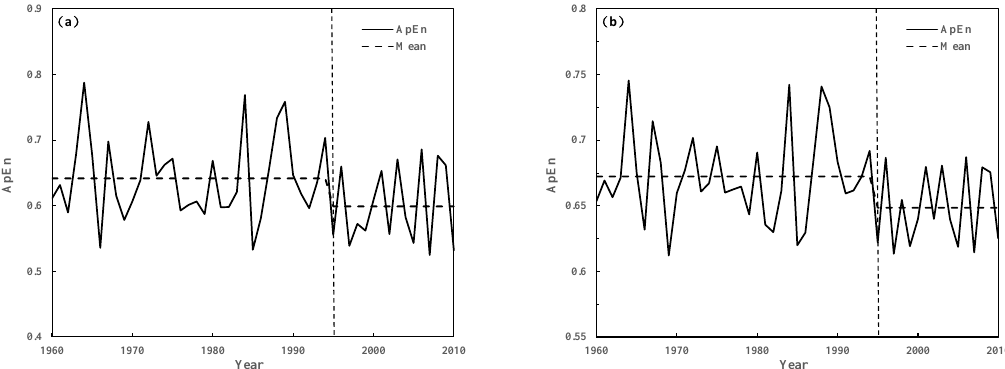
Figure 4. The ApEn of monthly mean precipitation ( a ) and runoff ( b Figure4. The ApEn of monthly mean precipitation ( a ) and runoff ( b ).